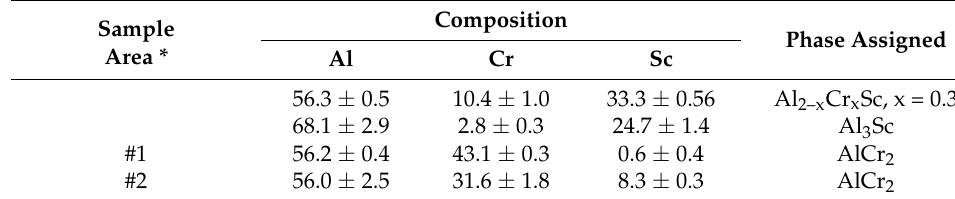
Figure 4. DSC heating and cooling curves of a piece of arc-melted sample III with rates of 3 °C/min. Inset: SEM/BSE image of the resulting microstructure with the indicated phases that were formed during the DSC experiment. Table 3. Chemical compositions that were measured in different areas of sample III after the DSC experiment (Figure 4), together with the corresponding experimental uncertainties.